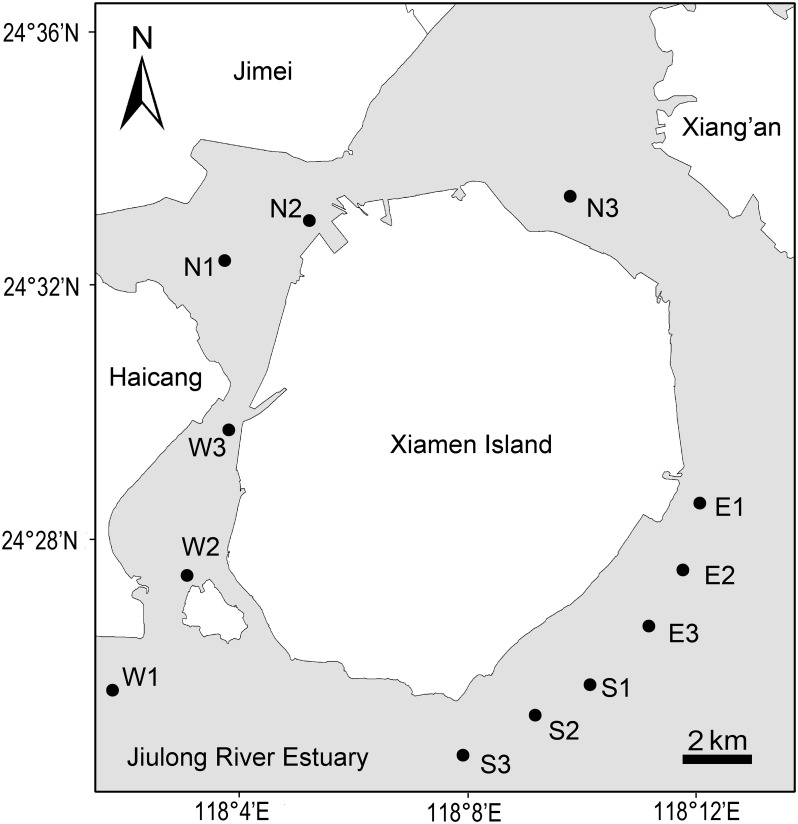
Map of Xiamen offshore sea area showing the locations of twelve sampling sites.